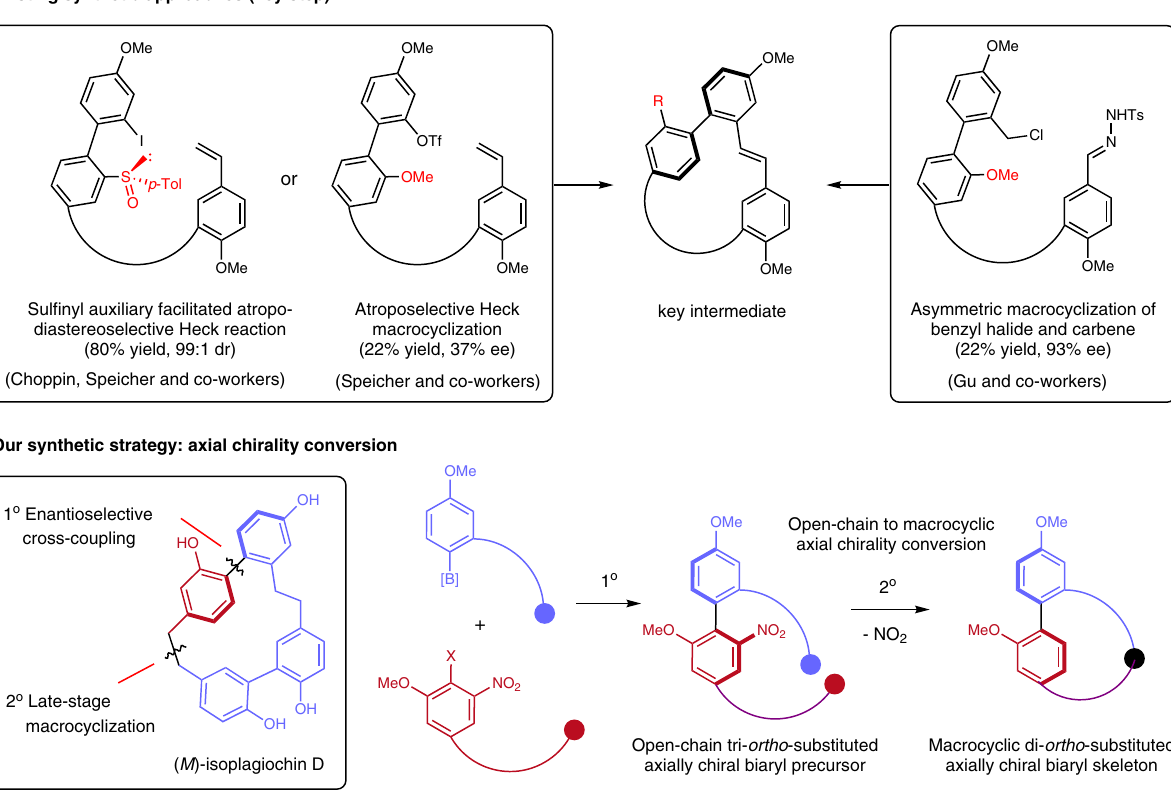
Fig. 5 | Strategies towards enantioselective synthesis of isoplagiochin D. a Reported asymmetric synthesis of isoplagiochin D (key step). b Our synthetic